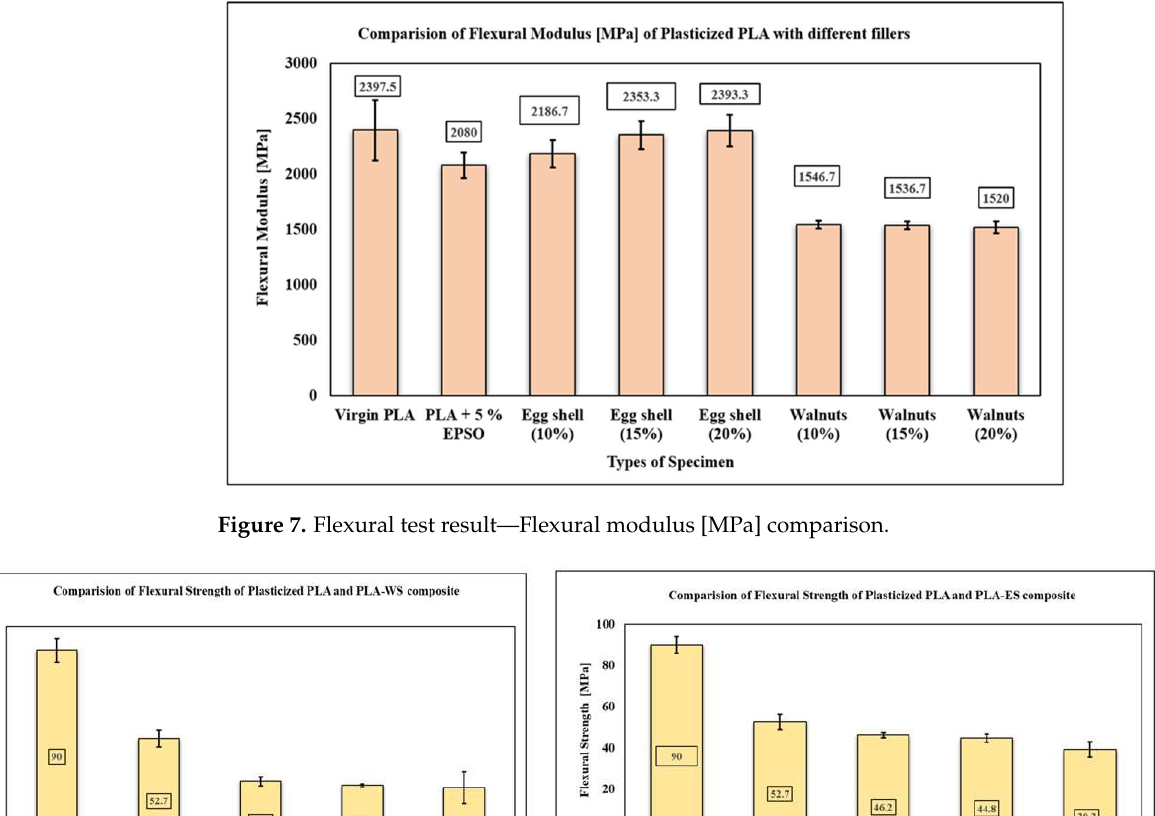
Figure 8. Flexural test result—Flexural strength [MPa] of PLA–ES composite compared with Virgin PLA.